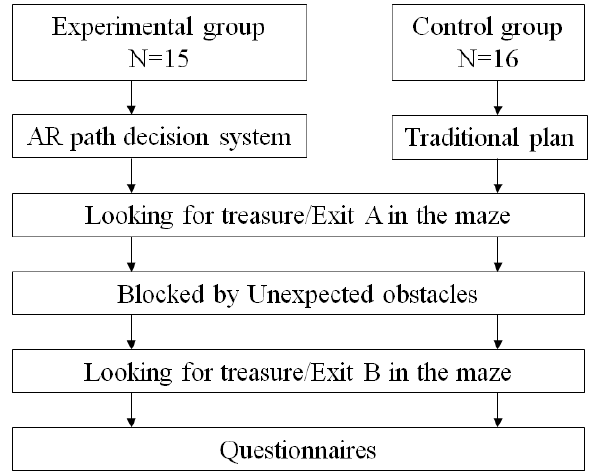
Figure 7. Experimental procedure.